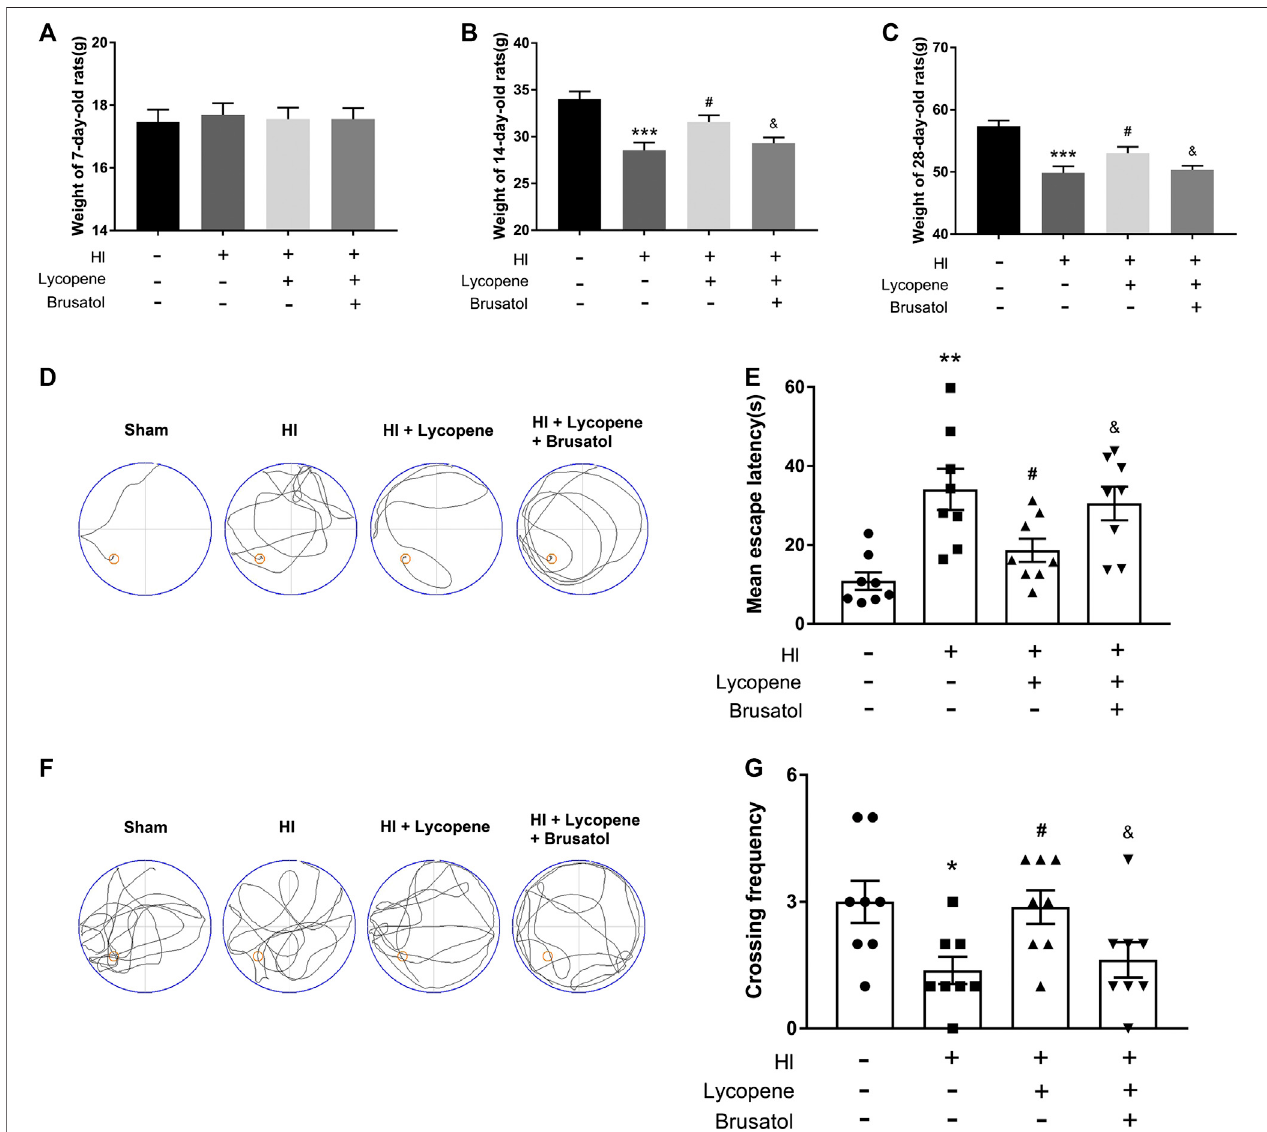
FIGURE5| TreatmentwithLycopene (Lyc) ameliorated thebodyweight and learningand memory ability ofratsafter HIinjury. (A) Theweights ofratsfrom different groupsarecomparedonday7.Alldataarepresentedasmean ± SEM,n (cid:2) 10. (B) Theweightsofratsfromdifferentgroupsarecomparedonday14.*** p < 0.001vs.the shamgroup; # p < 0.05vs.theHIgroup; & p < 0.05vs.theHI+Lycgroup.Alldataarepresentedasmean ± SEM,n (cid:2) 10. (C) Theweightsofratsfromdifferentgroupsare comparedonday28.*** p < 0.001vs.theshamgroup; # p < 0.05vs.theHIgroup; & p < 0.05vs.theHI+Lycgroup.Alldataarepresentedasmean ± SEM,n (cid:2) 8. (D) Representative ofswim route traces ofrats from differentgroups. (E) Quantitative analysisofmean escape latency ofMorris WaterMaze tests in different groupsof rats. ** p < 0.01 vs. the sham group; # p < 0.05 vs. the HI group; & p < 0.05 vs. the HI + Lyc group. All data are presented as mean ± SEM, n (cid:2) 8. (F) Representative images of swimroutetracesofratsfromdifferentgroupsafterremovaloftheplatform. (G) Quantitativeanalysisofthefrequencyofcrossingtheoriginalplatformlocationinthe60s. * p < 0.05 vs. the sham group; # p < 0.05 vs. the HI group; & p < 0.05 vs. the HI + Lyc group. All data are presented as mean ± SEM, n (cid:2) 8.